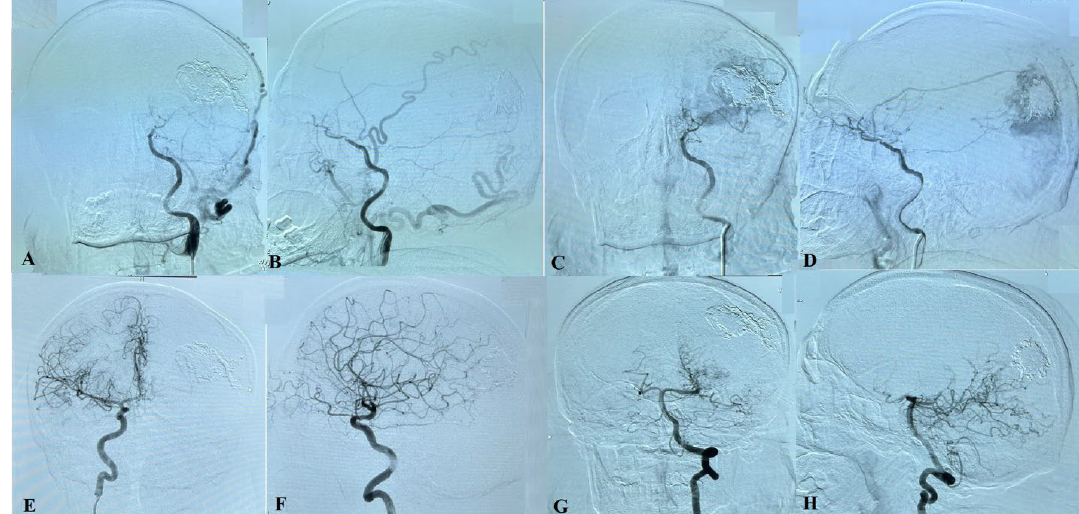
Figure 7. A carotid angiogram from the left ICA ( A – D ) demonstrates occlusion of the left ICA at the level of the ophthalmic segment. A cerebral angiogram from the right ICA ( E , F ) and the left vertebral artery ( G , H ).